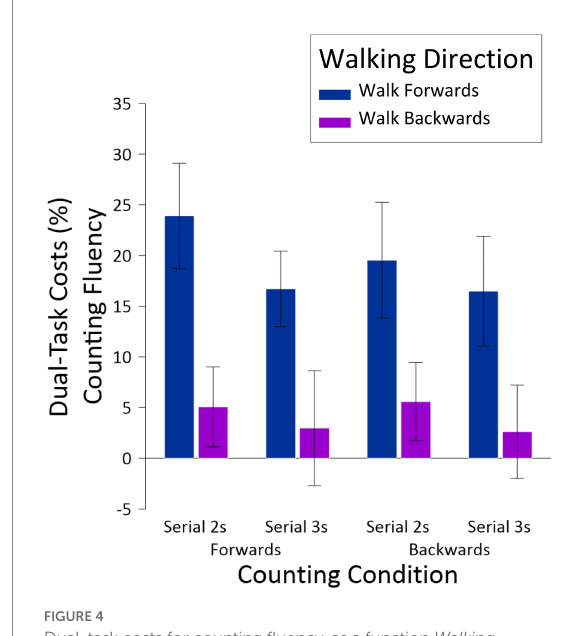
FIGURE 4 Dual-task costs for counting fluency, as a function Walking Direction, Counting Direction , and Counting Difficulty . Dual-task costs for counting accuracy could not be calculated due to the relative paucity of errors in the single-task condition (see Figure